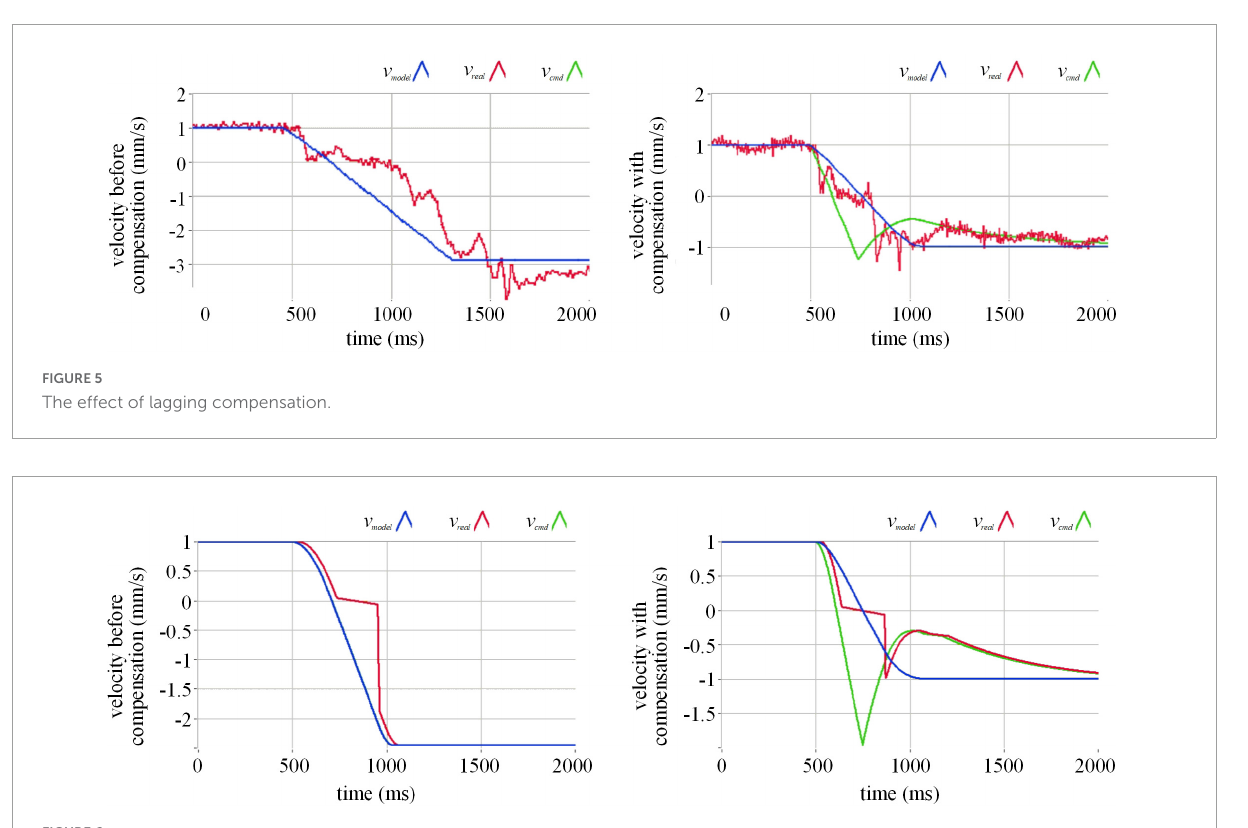
FIGURE6 The effect of actuation compensation at velocity 1 mm/s in simulation. Where the blue line represents the command velocity, the red line the execution velocity, and the green line the command velocity after the compensation.